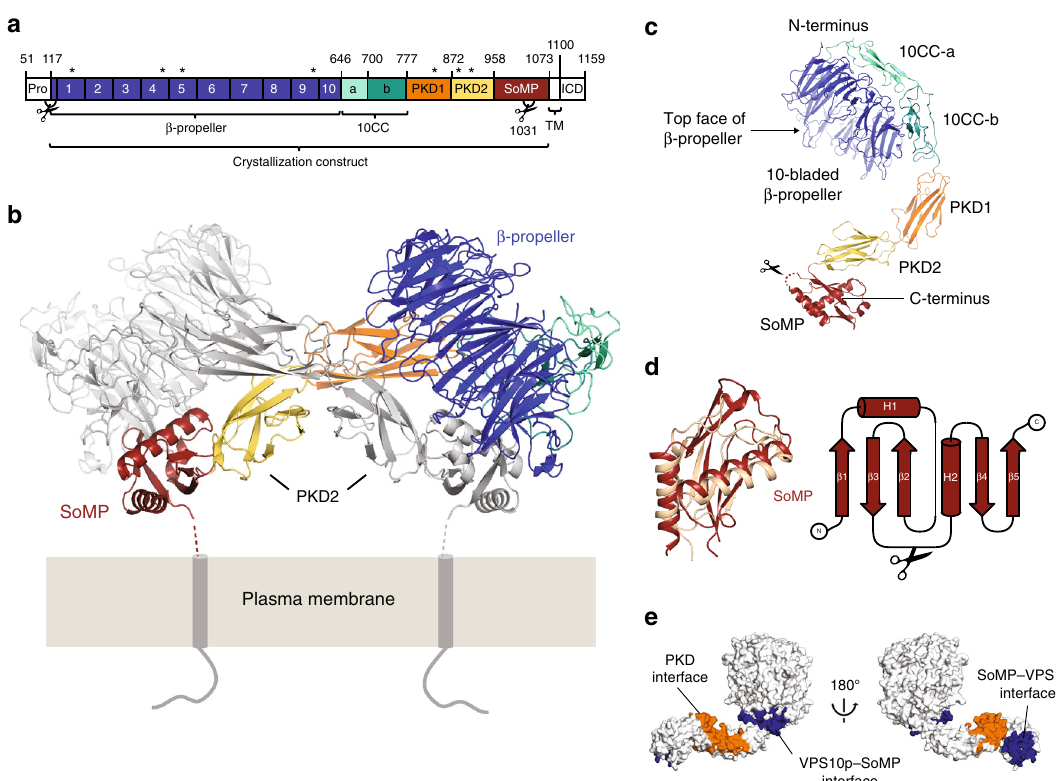
Fig. 1 SorCS2 forms a cross-braced homodimer. a Schematic representation of SorCS2 with the different domains colored and the ten blades of the β - propeller numbered. The second PKD domain and the SoMP domain were previously unreported and together with PKD1 constitute the leucine rich repeat region. Predicted N-glycosylation sites (stars), proteolytic processing sites (scissors), pro domain (PRO), transmembrane domain (TM) and intracellular domain (ICD) are also indicated. b Cartoon representation of the structure of the unliganded sSorCS2 dimer (one monomer colored according to ( a ), the other monomer colored gray). The predicted orientation and connection to the cell surface of sSorCS2 are indicated. Seven residues are lacking between the structure and the two transmembrane helixes. The top faces of the β -propellers are slanted towards the cell membrane. The SoMP domain is folded and interacts with the β -propeller of an opposing monomer, essentially cross-bracing the dimer. c One chain of the sSorCS2 dimer in cartoon representation and colored as in ( a ). The processing site at S1031 4 (scissors) resides in a disordered loop that is located close to the cell surface. d SoMP has a fold similar to an RNA Recognition Motif. Superposition of the SorCS2 SoMP domain (red) and the RNA recognition motif of yeast eIF3b 66 (pdb 3NS5, yellow) (left panel). Topology diagram of SorCS2 SoMP with secondary structure elements indicated (right, panel). Processing site (scissors) as in ( c ). e Residues involved in dimer formation colored orange for the PKD – PKD interface and blue for the SoMP – VPS10p